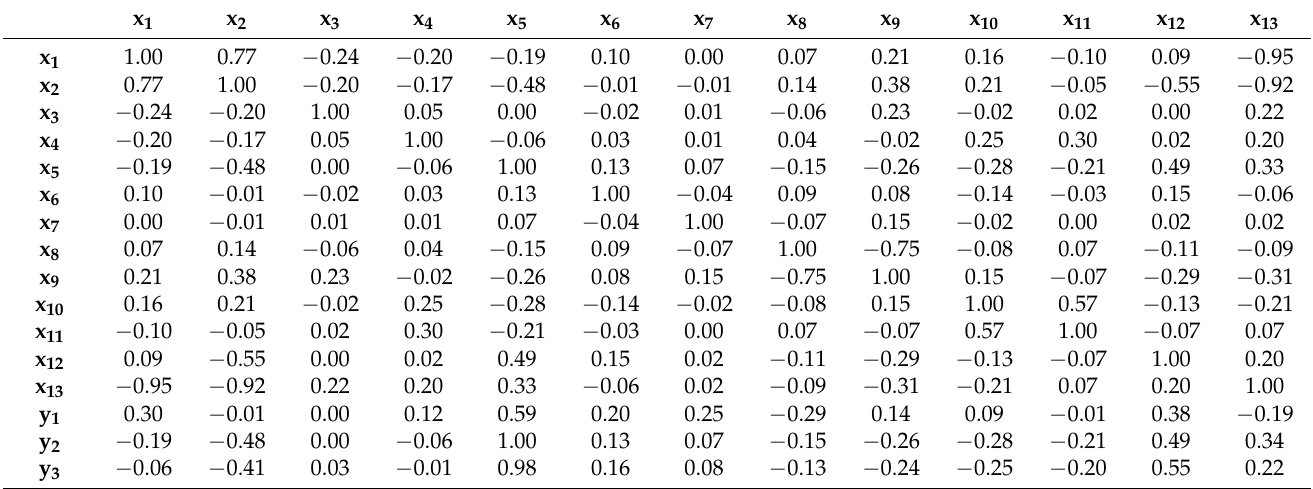
Table A1. Correlation coefficients for input and output variables x 1 –x 13 , y 1 –y 3 .